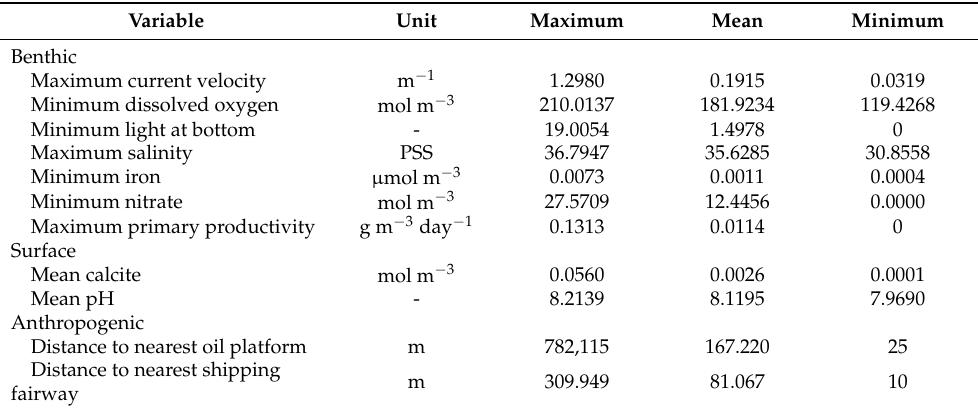
Table 1. Units and descriptive statistics for the nine environmental variables and the two anthro- pogenic